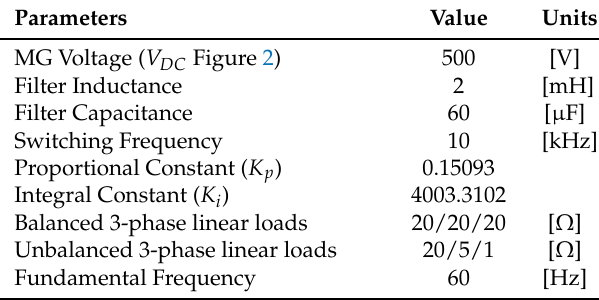
Table 7. Parameters of MG model for PI-LQR